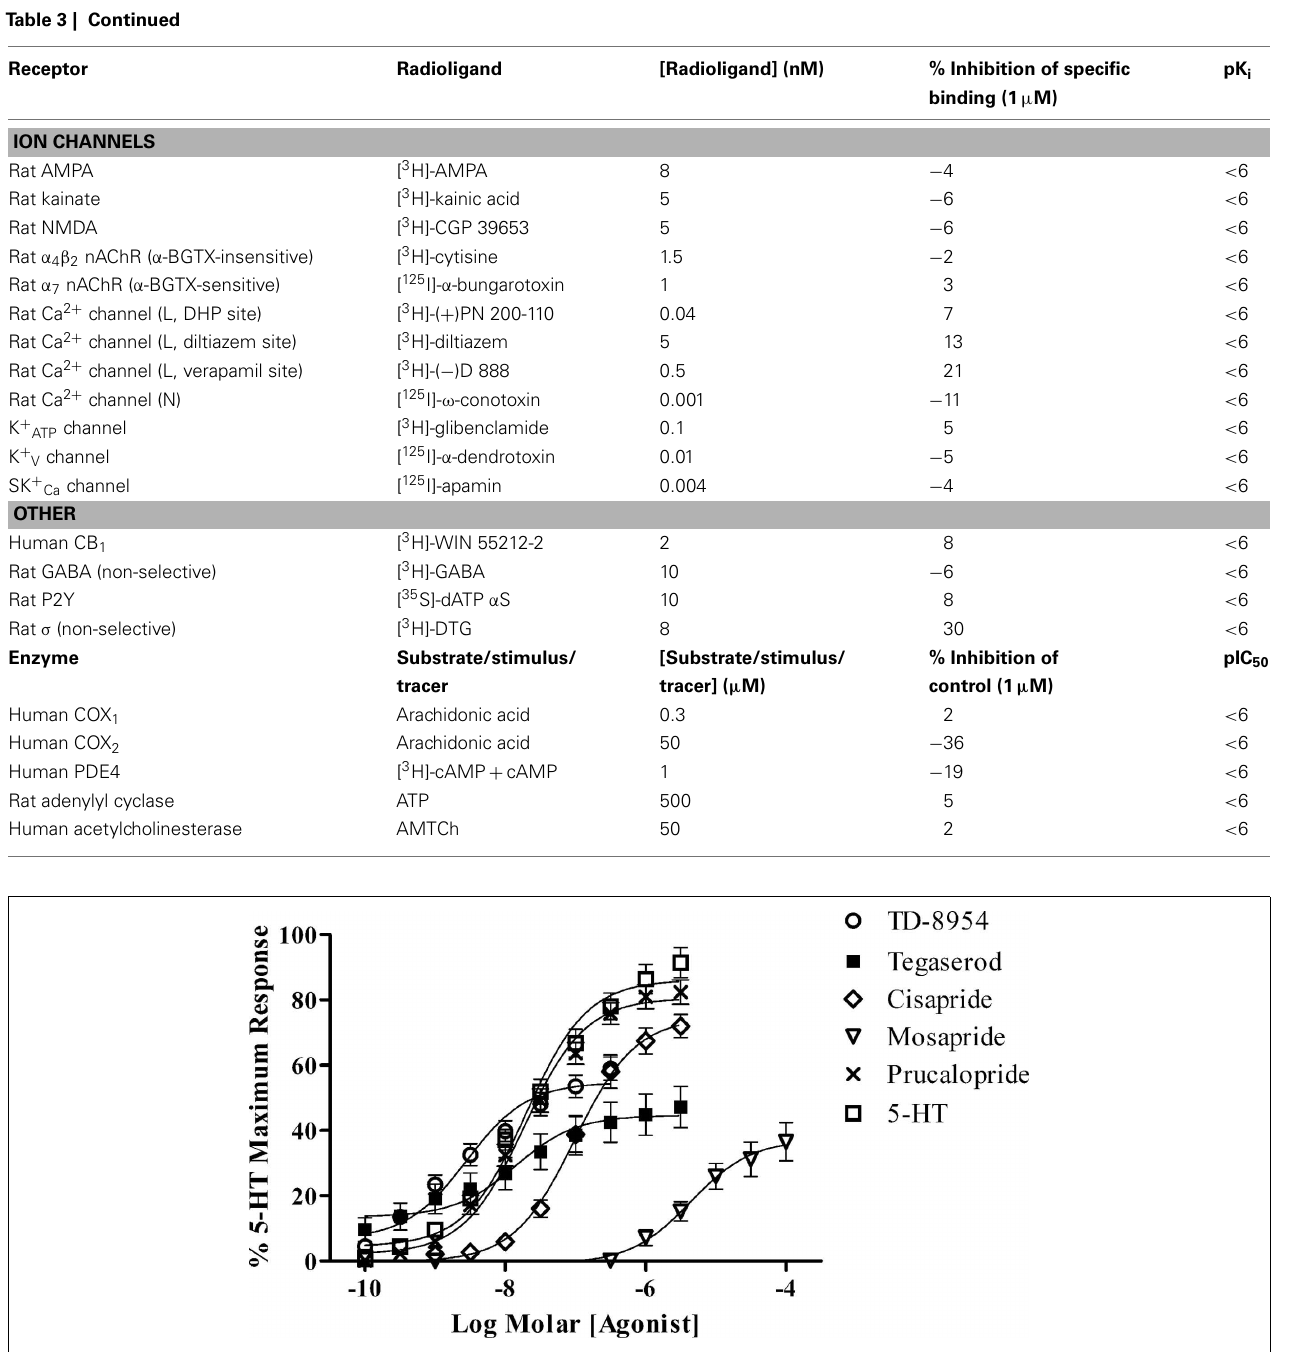
LMMP preparation. Values are expressed as the mean ( ± SEM) change in tension, as a percentage of the primed 5-HT (0.3 μ M) response in the same